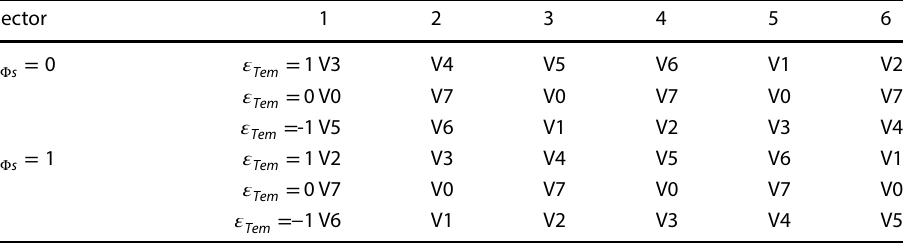
Table 3 Switching Table